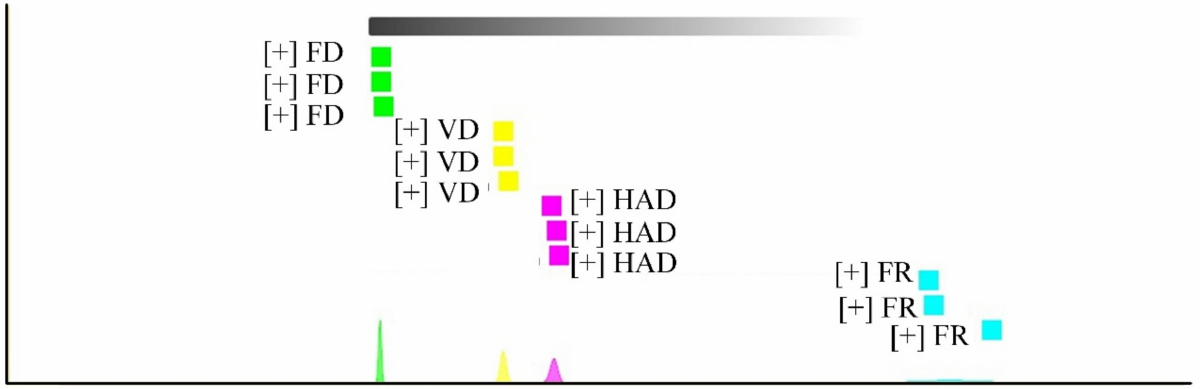
Figure 5. Fingerprint similarity based on the Euclidean distance of the fresh and dried AMR samples treated by using different drying methods. (green indicated FD, yellow indicated VD, pink indicated HAD, blue indicated